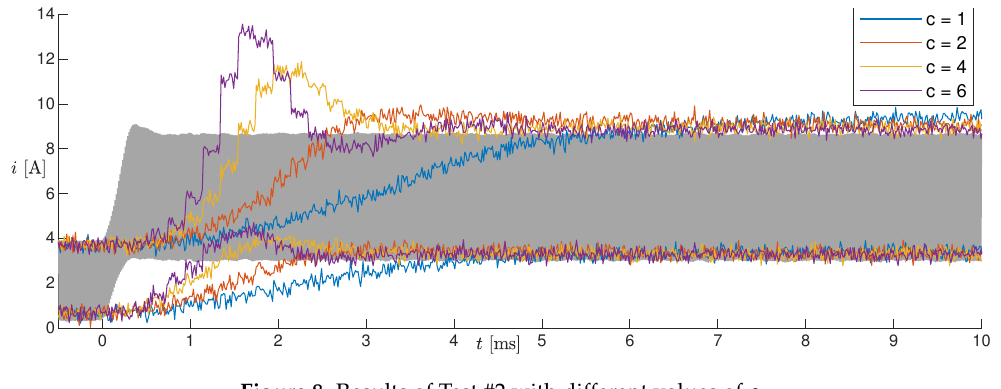
Figure 8. Results of Test #2 with different values of c